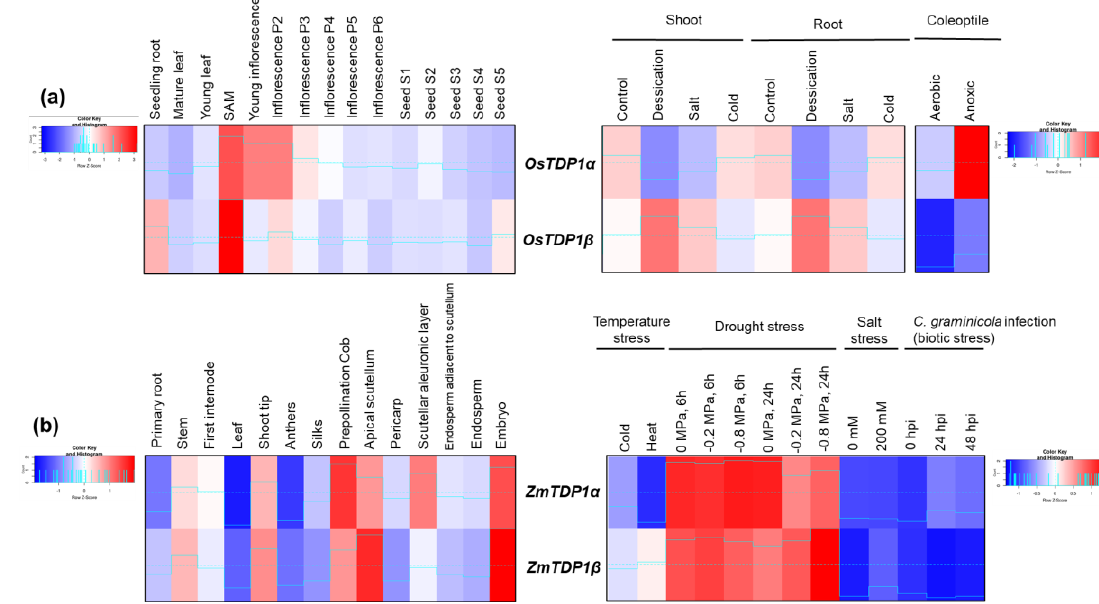
Figure 5. Expression profiles of the TDP1α and TDP1β genes in cereal crops. ( a ) O. sativa. ( b ) Z. mays. Expression data from different tissues and stress conditions are given in heatmaps generated based on Z-score values at http://shinyheatmap.com/.